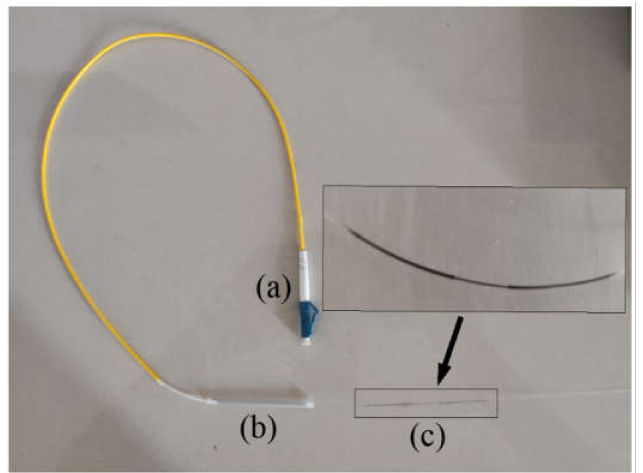
Figure 10. Optical fiber grating hydrogen sensor. ( a ) LC jumper; ( b ) Heat shrink tube; ( c ) Hydrogen- sensitive